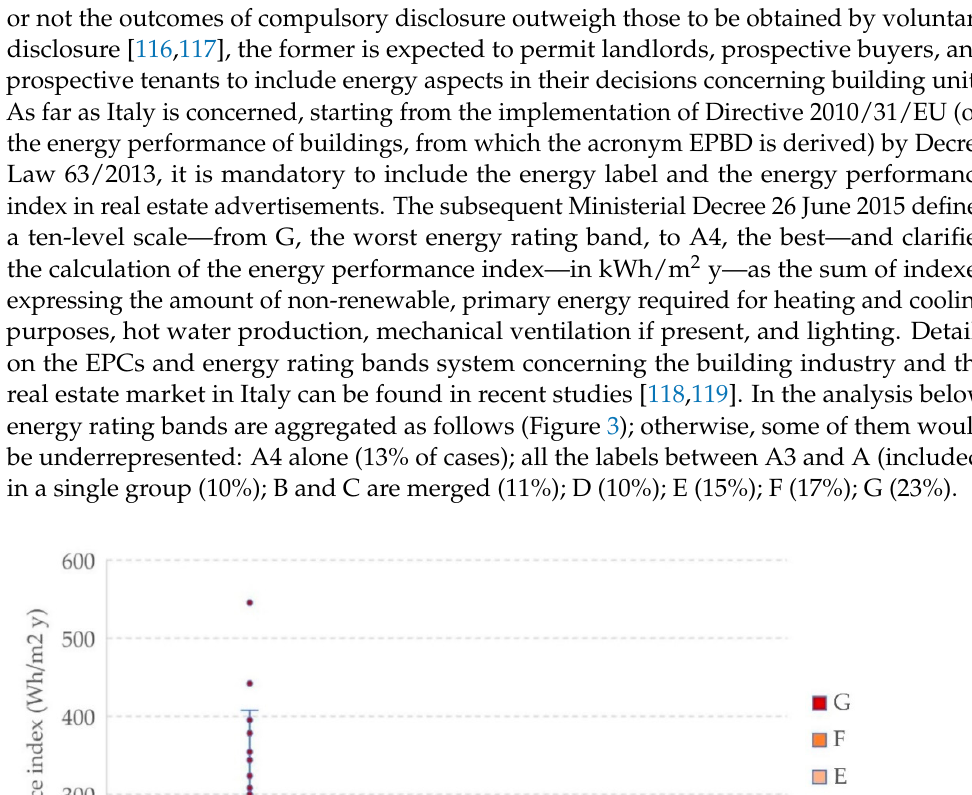
9 of 23 Figure 2. Location of the analyzed properties: on the aerial view of the city of Padua from Google Earth ( left panel) and the urban fabric plus population density ( right panel). The gathering of data on the energy performance index and energy rating band for each property for sale is made possible by a recent shift in energy policies, namely, the